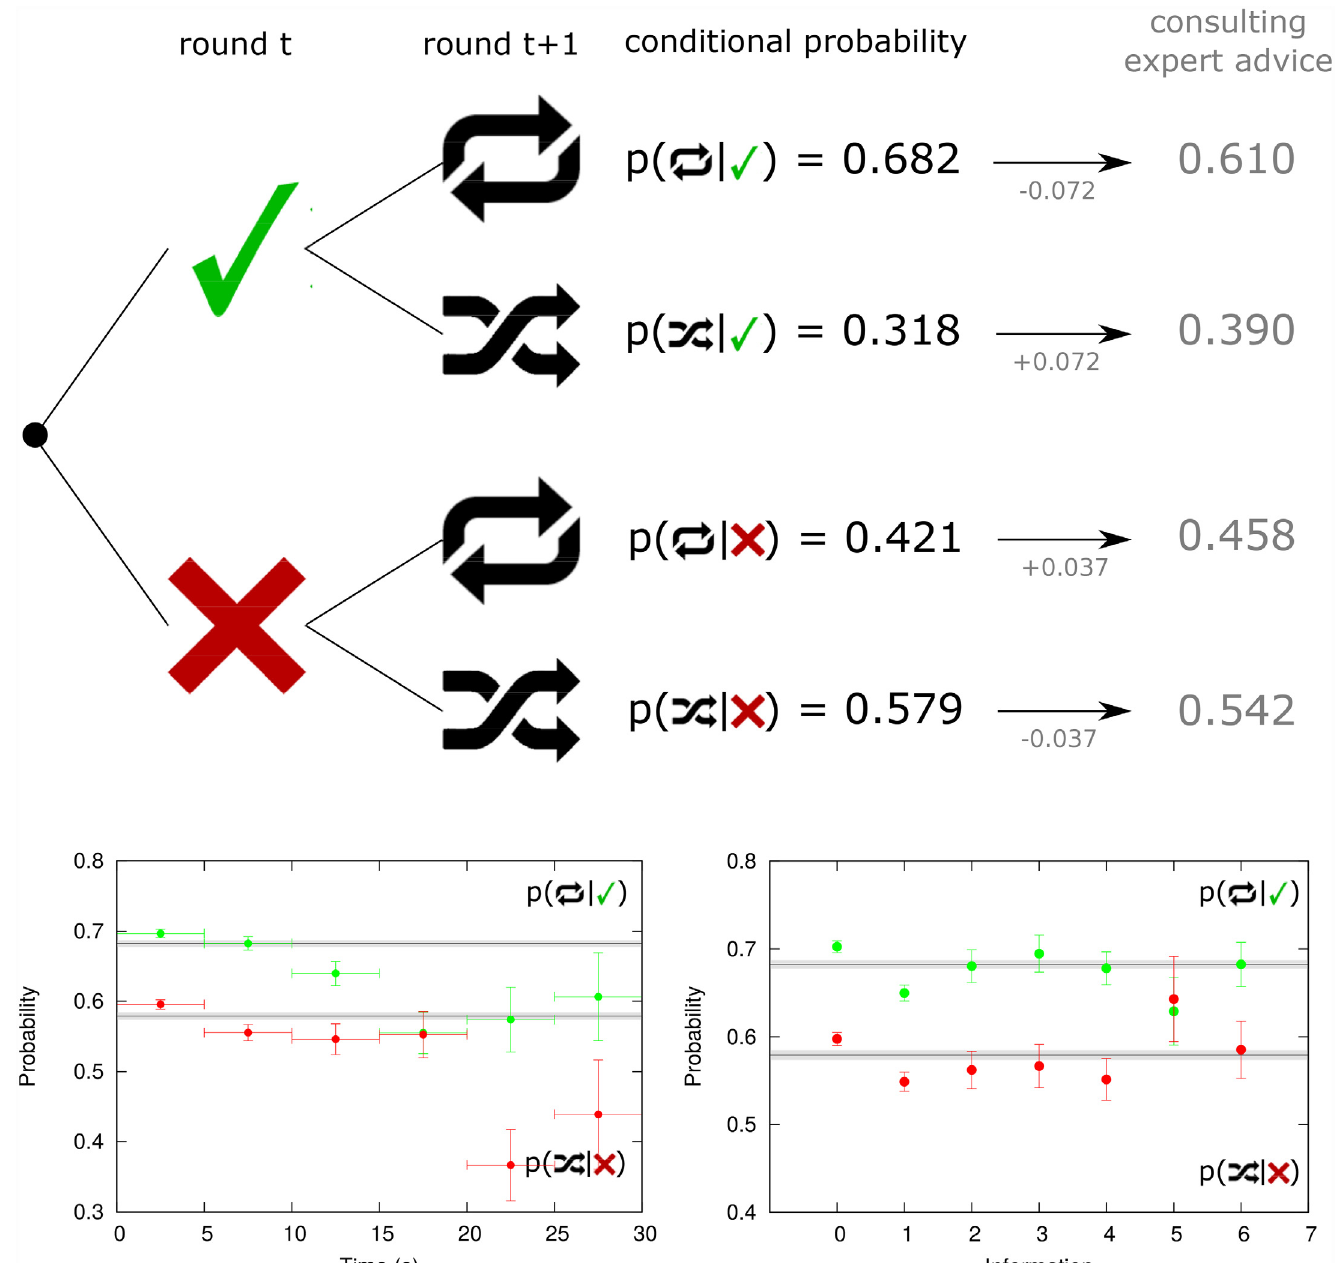
Fig 4. Decision conditioned to performance: the Win-Stay Lose-Shift emerging strategy. Empirical conditional probabilities of repeating previous guess are positively correlated with success and failure of the previous guess. The highest probability corresponds to repeating the previous guess when this was correct (0.682). The expert ’ s advice partially neutralizes the effect (0.610). (down left) The conditional probability decreases when participants spend more time to make the decision in both cases: being “ correct ” (green) and being “ wrong ” (red) in the previous round. (down right) The conditional probability initially diminishes but when a participant consults more information it oscillates around the mean in both cases: being “ correct ” (green) and being “ wrong ” (red) in the previous round. Horizontal lines in bottom plots provide aggregated results and shadows their error bars. Error bars represent the Standard Deviation of a binomial